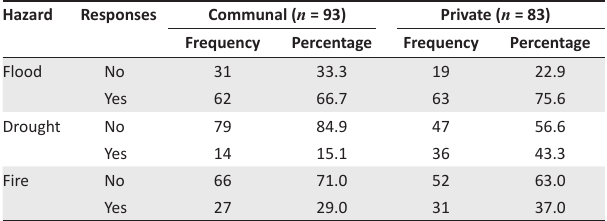
TABLE 3: Common risks experienced in communal and private